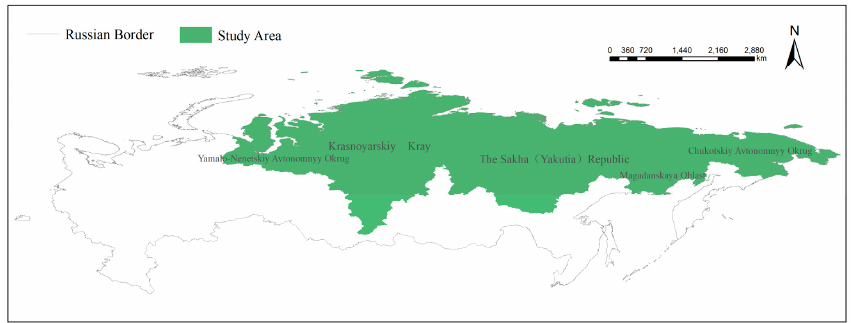
Figure 1. Study area in Siberia, Russia (Yamal-Nenets Autonomous Okrug, Krasnoyarsk Kray, Ya- kutia, Magadan Oblast, and Chukotka Autonomous